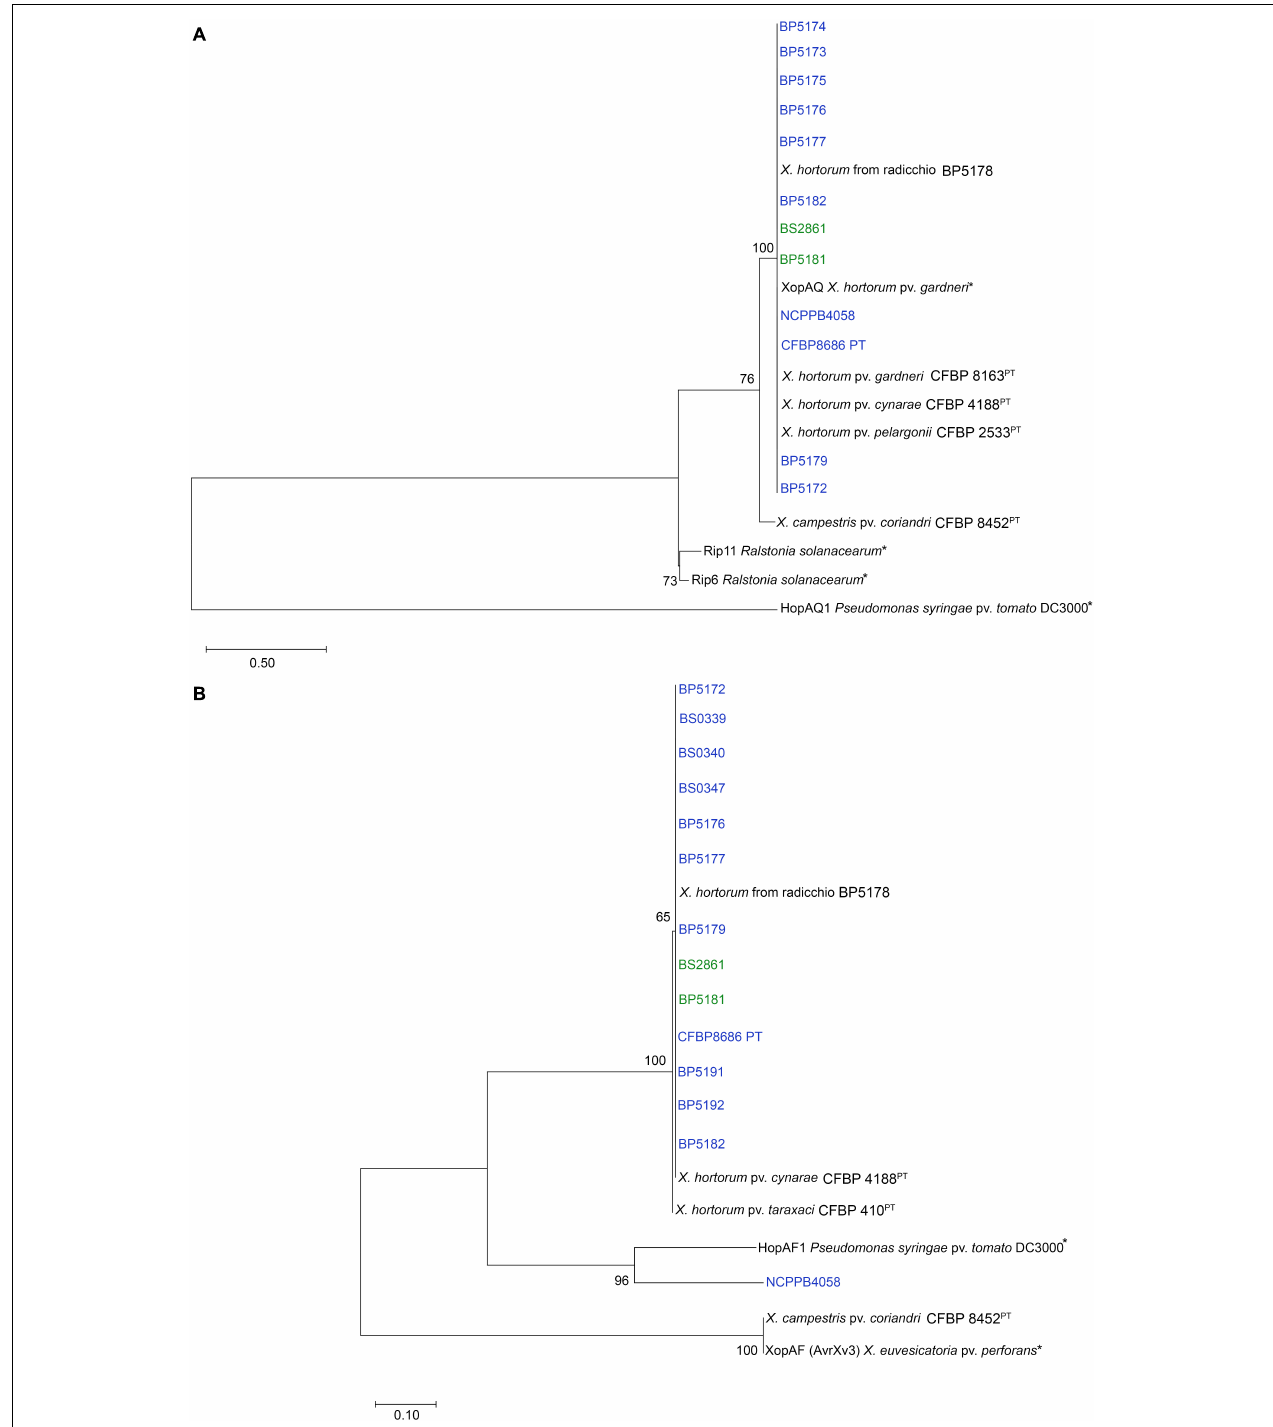
FIGURE 4 | Phylogenetic trees constructed from (A) XopAQ amino acid alignment and (B) XopAF amino acid alignment. Maximum-likelihood phylogenies were constructed for the two genes present in Xhv race 1 and race 3 strains (blue and green) but missing from Xhv race 2 strains. Nucleotide sequences for these genes were extracted from the whole genome sequence assemblies and converted to amino acid sequences using OrthoFinder. Alignments and trimming were completed using MEGA11, as well as the phylogeny building using the Jones-Taylor-Thornton (JTT) substitution model, uniform substitution rates among sites, and nearest-neighbor-interchange (NNI) method for tree inference. Bootstrap values are shown beside branches and branch length represents the expected number of amino acid substitutions per site. Asterisks indicate published sequences used as references for proteins HopAF1 and XopAF (Astua-Monge et al., 2000; Petnicki-Ocwieja et al., 2002) and XopAQ, HopAQ1, Rip6, and Rip11 (Guttman et al., 2002; Mukaihara et al., 2010; Potnis et al., 2011).